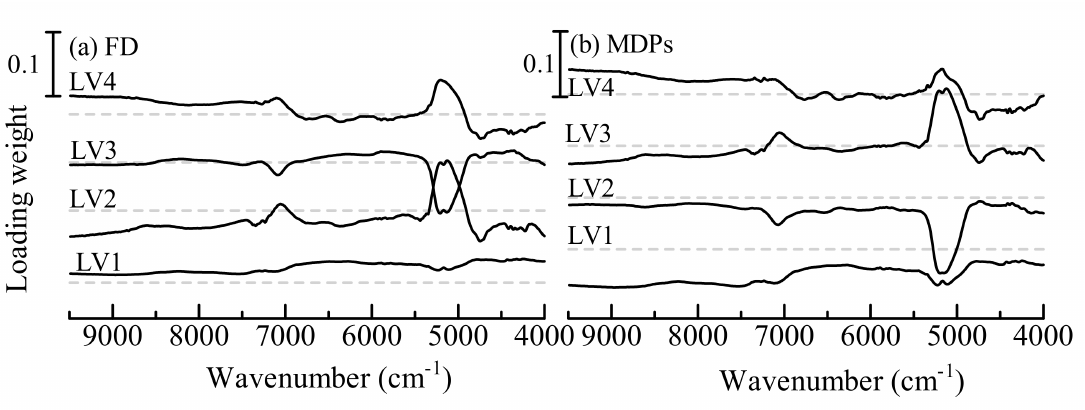
Figure 1. The loading weight of the first four latent variables (LVs) in near-infrared spectra for the control model of fill depth (FD) ( a ) and minimum distance between punches (MDPs) ( b ). The gray dashed lines indicate the zero-weight level for each